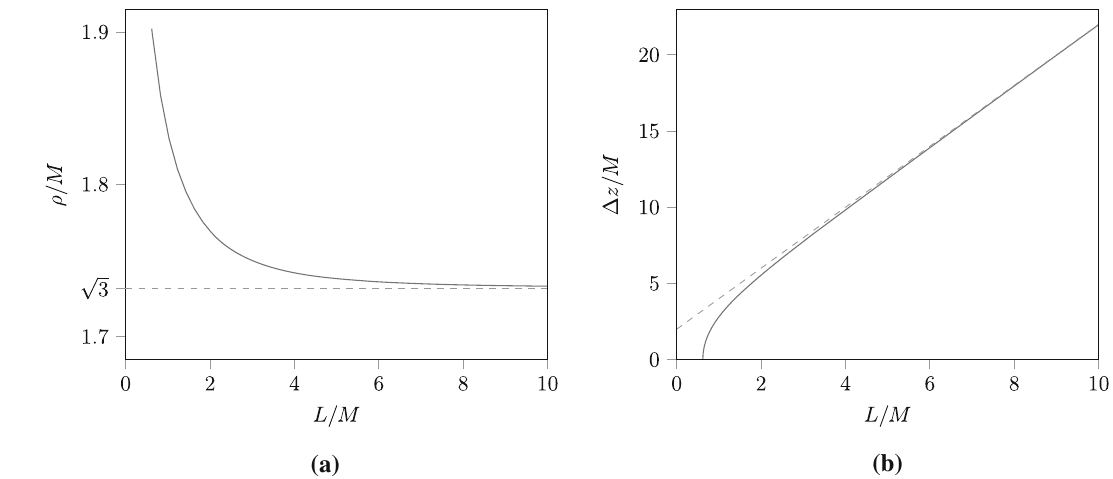
Fig. 4 Plot of a ρ against L , and b (cid:10) z against L , for the off-equatorial LRs. These plots asymptotically approach the dashed lines shown. The √ dashed line in a corresponds to the value ρ = 3 M , while that in b corresponds to (cid:10) z = 2 ( M + L )